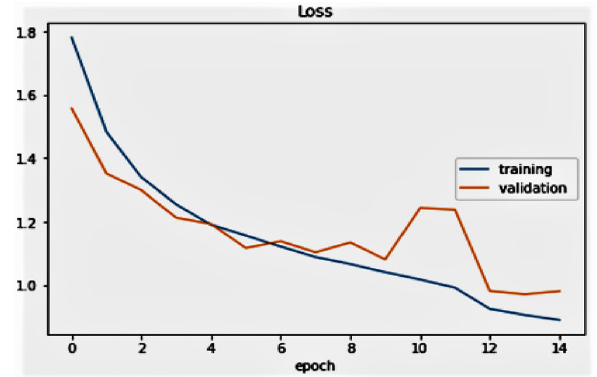
Figure 16. Graphical view of training and validation loss per epoch.